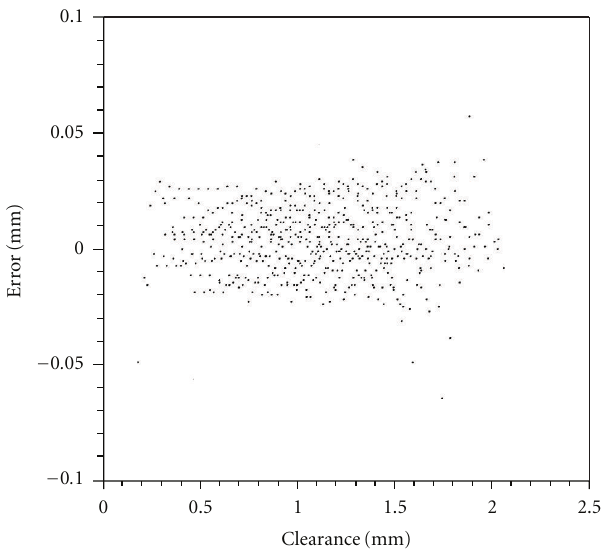
Figure 10: Error in FM capacitance probe measurement, calculated by subtracting the known clearance between probe and blade tip from that obtained using the probe calibration for each blade.